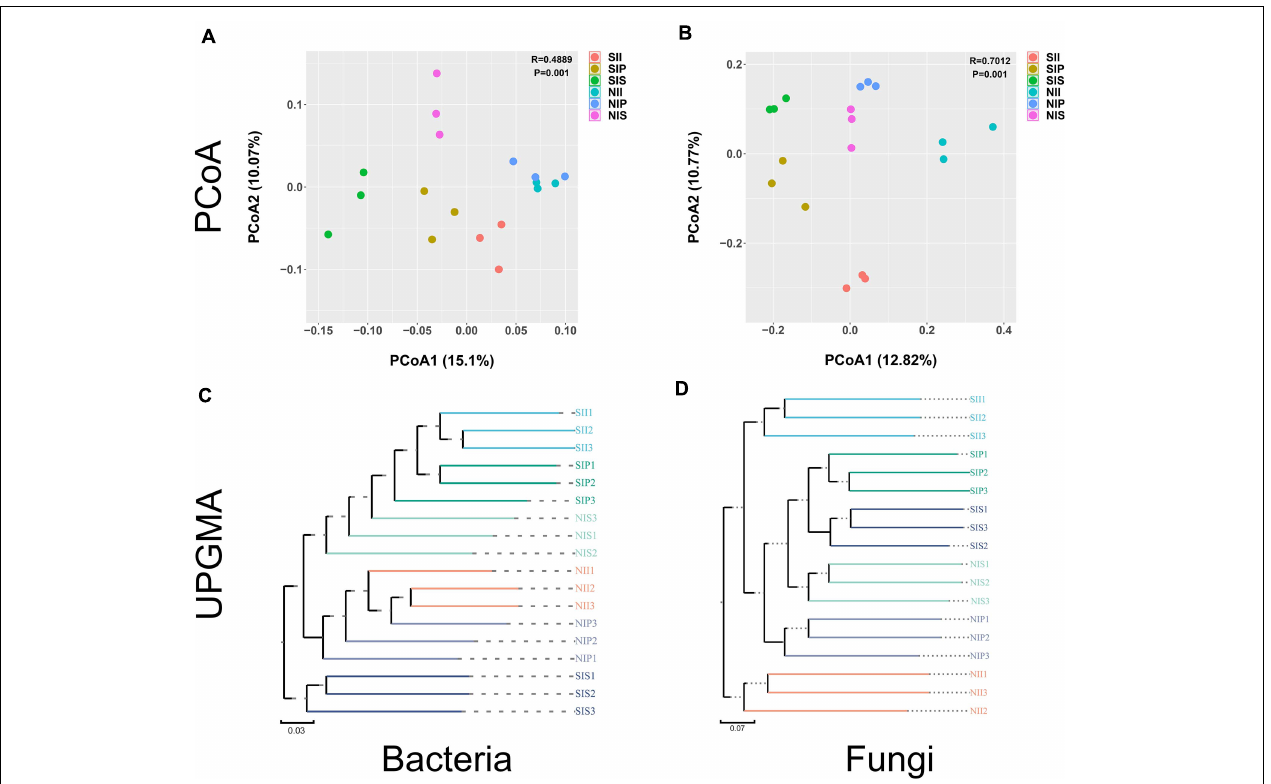
FIGURE 5 | Principal coordinate analysis and unweighted pair group method with arithmetic mean analysis of the peanut rhizosphere (IP), sorghum rhizosphere (IS), and interspecific interaction zone (II) microbial communities at the phylum level under different soil conditions (S, 0.25% salt-treated soil condition; N, normal soil condition). (A) PCoA of bacterial community composition. (B) PCoA of fungal community composition. (C) UPGMA cluster analysis of bacterial community composition. (D) UPGMA cluster analysis of fungal community